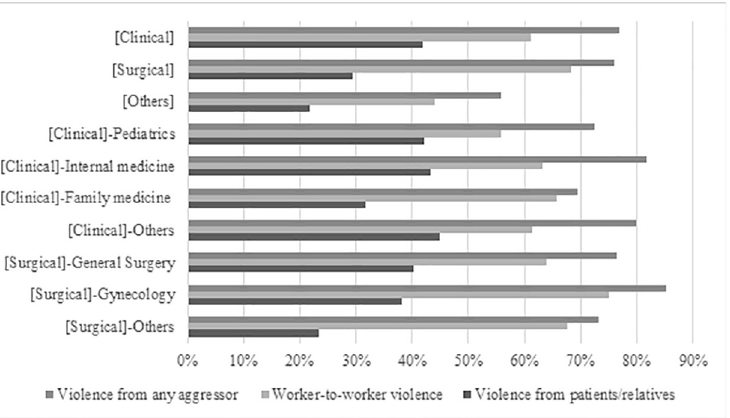
Fig 1. Prevalence of workplace violence according to specialty. Specialty